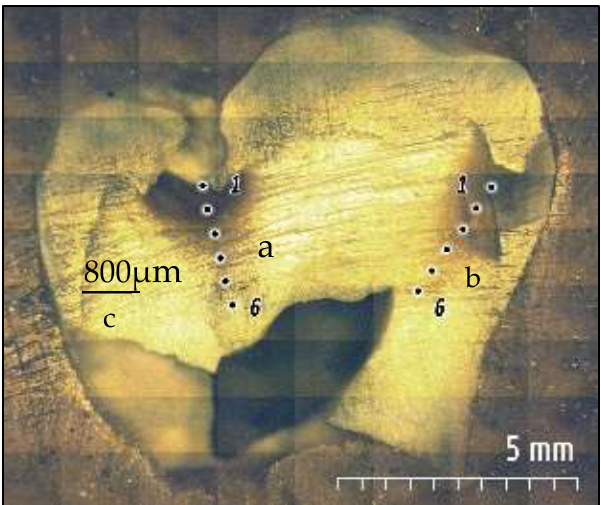
Figure 1. The prepared lesion hemi-section was firstly analyzed using confocal Raman microscopy followed by Vickers microhardness indenter across the lesion. The assessment started from the enamel–dentin junction through the lesions towards the pulp in a straight path occlusally (a) and an oblique path proximally (b). A control measurement was taken in an area of clinically sound dentin (c) in the same sample. Six measurement areas were taken in each lesion with a 500 µ m distance between the examined points.